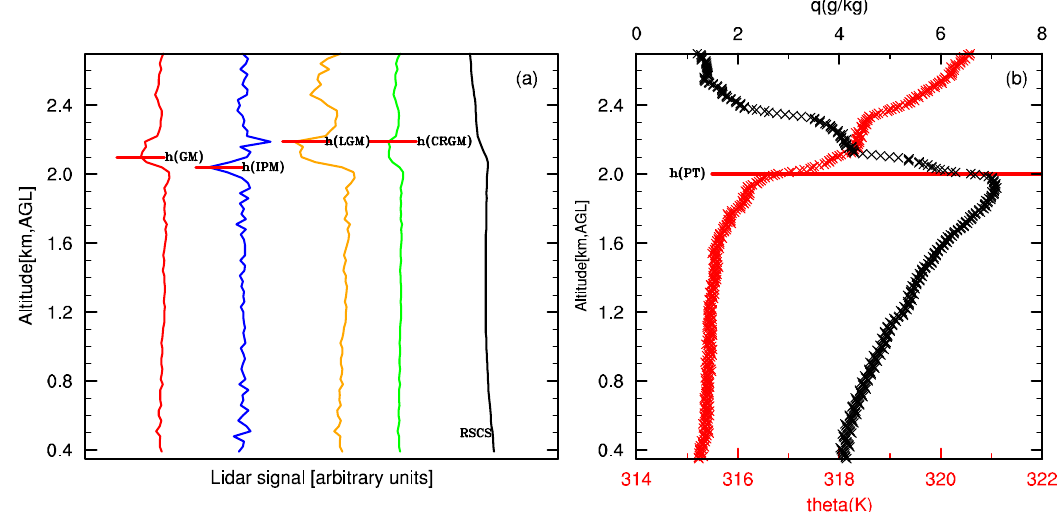
Figure 3. A case at 12:00 UTC on 10 September 2010 over SACOL (Semi-Arid Climate Observatory and Laboratory, in China). ( a ) the profiles of lidar range-squared-corrected signal (RSCS, black solid line), first derivative (red solid line), second derivative (blue solid line), the logarithm gradient (orange solid line) and the cubic root gradient (green solid line) of RSCS provided by a micro-pulse lidar (MPL), the respectively determined ABLH are named as h(GM), h(IPM), h(LGM), h(CRGM), ( b ) the profiles of potential temperature (red profile) and the specific humidity (black profile) at a nearby radiosonde site with the CBLH determined by the theta-gradient method (h(PT)).